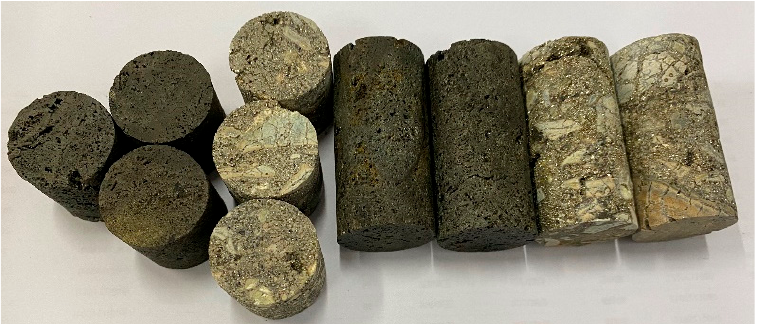
Figure 2. Processed test samples.